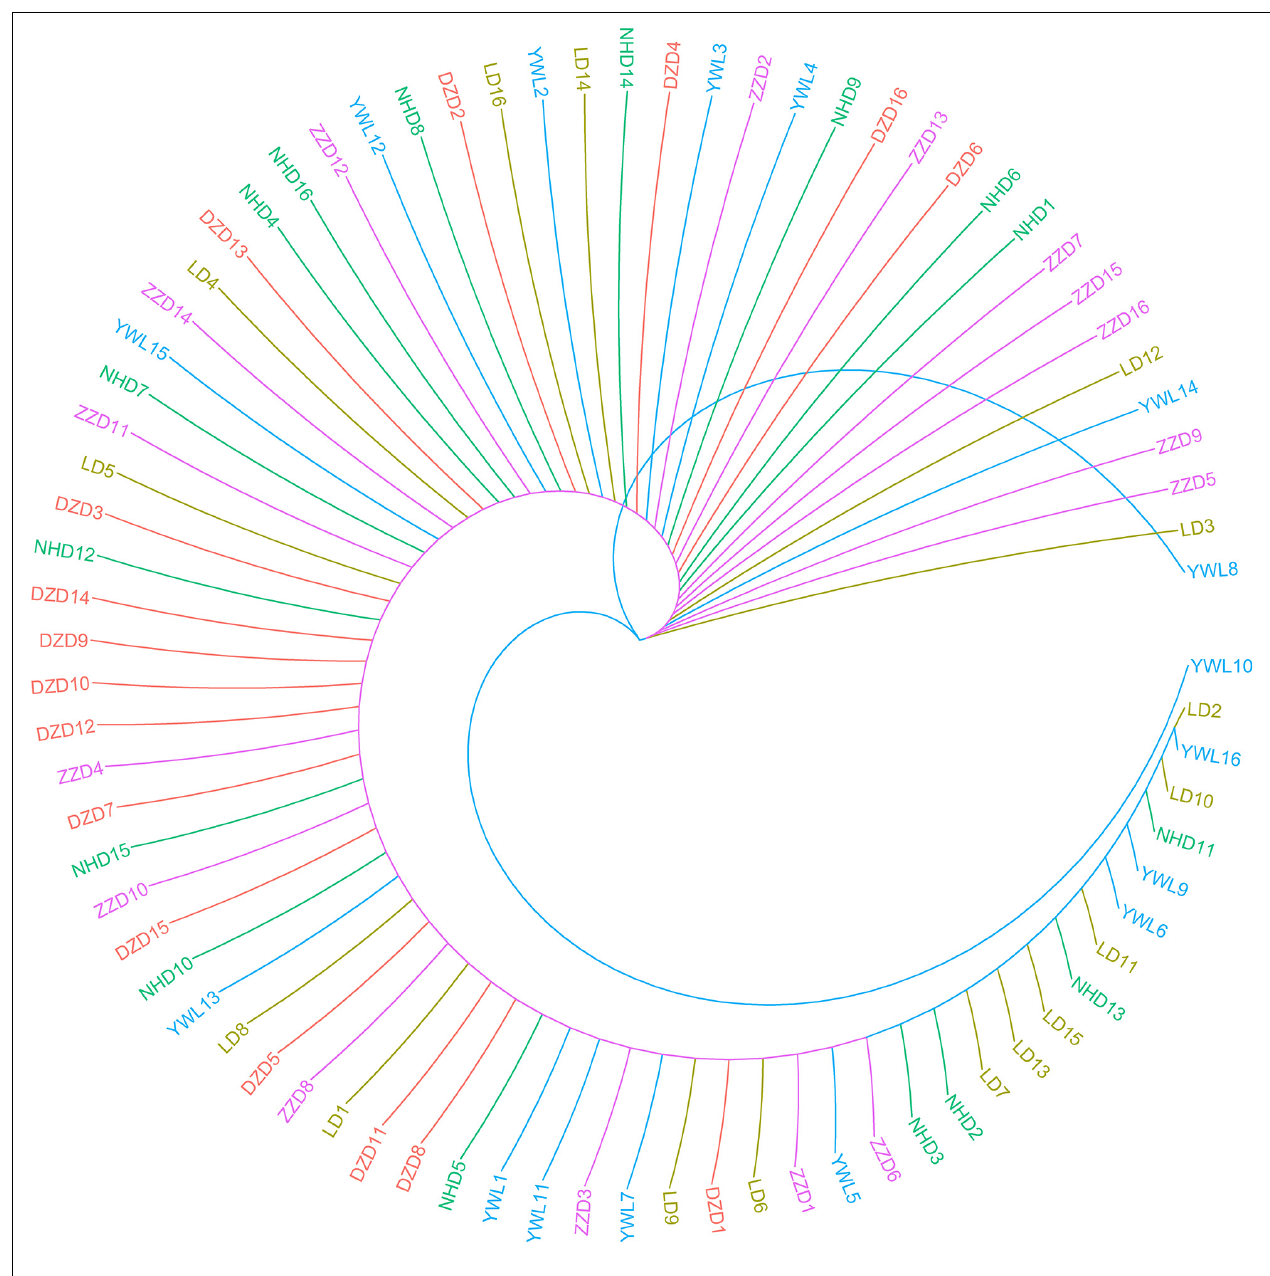
FIGURE 4 | Individual-level phylogeny constructed using